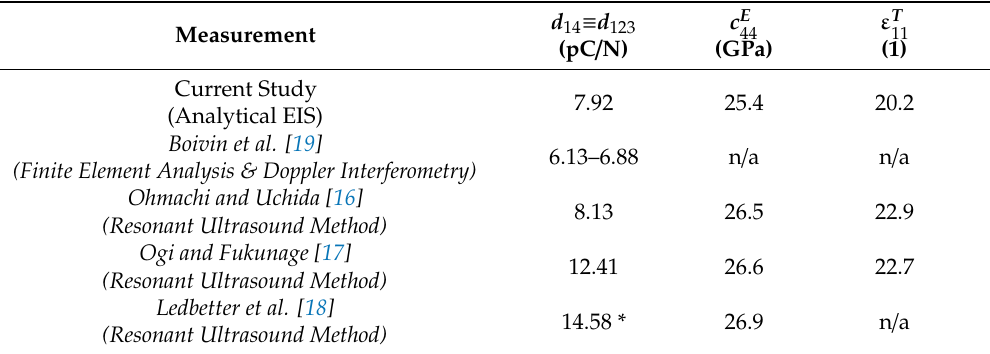
Table 1. Material properties of α -tellurium dioxide (paratellurite, α -TeO 2 ) experimentally determined in this study by analytical Electrochemical Impedance Spectroscopy (EIS) compared to values reported in the